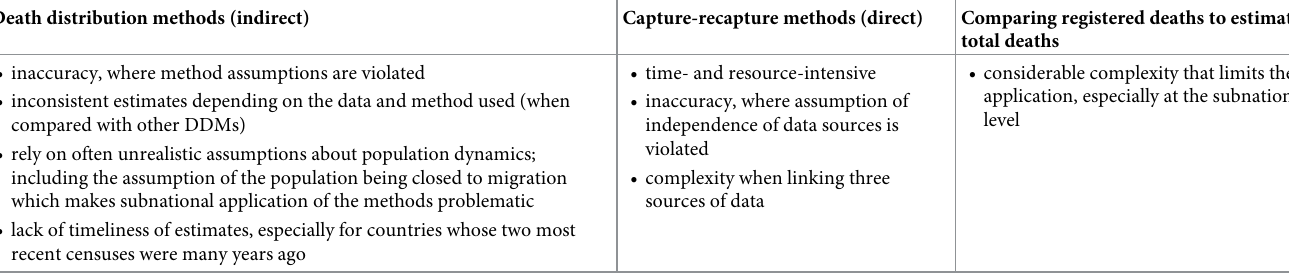
Table 1. Limitations of existing completeness